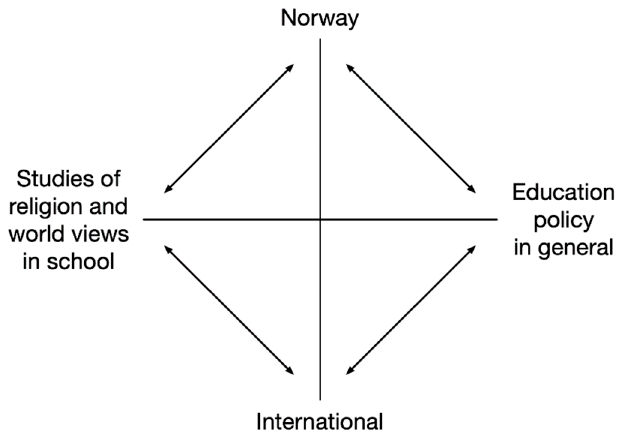
Figure 1. Axes of influence on religious education curricula.